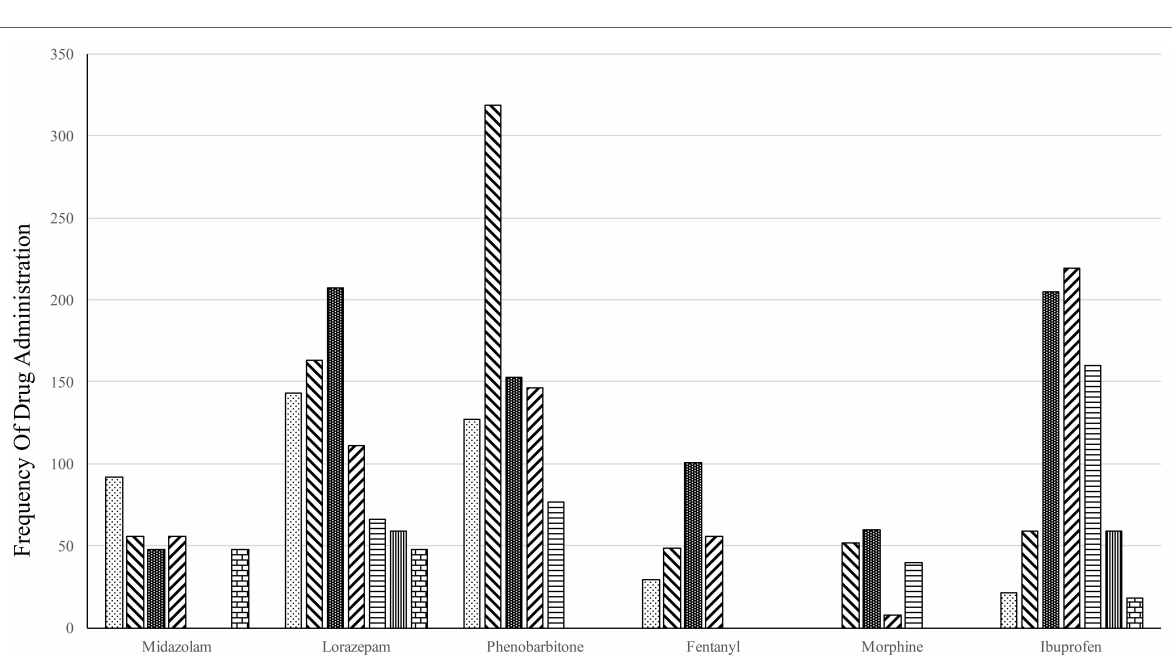
FigUre 2 | Distribution of pharmaceutical pain relief agents over first 7 days of admission .